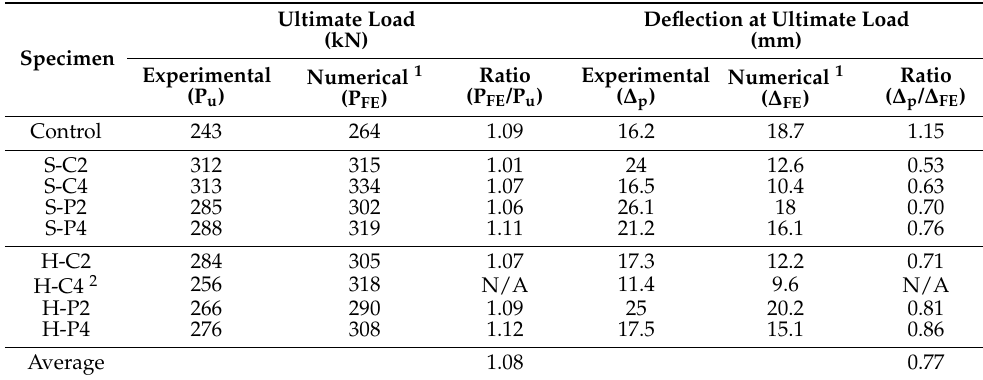
Table 8. Comparison between predicted and experimental ultimate